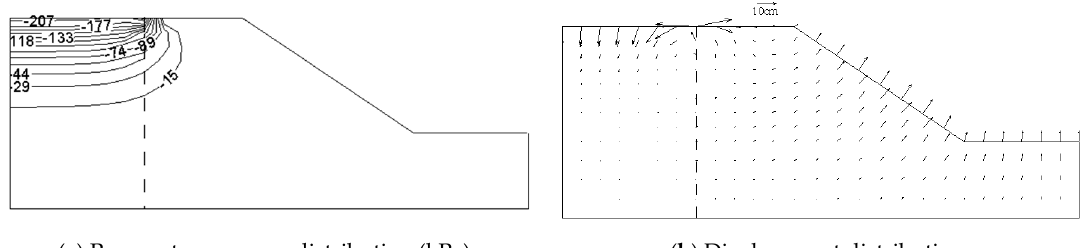
Figure 17. The distributions of pore water pressure and displacement at the end of evaporation under the condition of 1 kPa tensile strength.